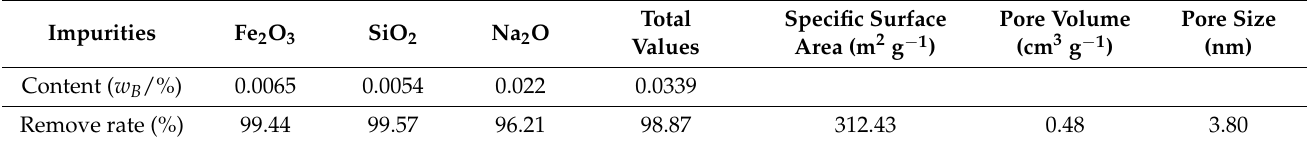
Table 9. Impurity mass fraction in the product mesoporous alumina and its